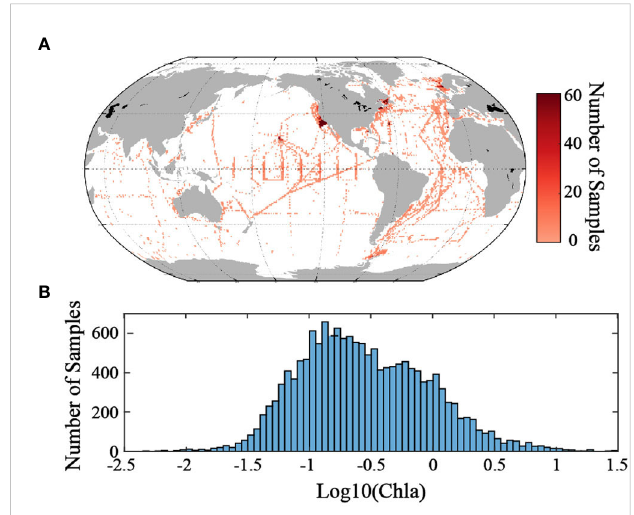
FIGURE 3 (A) Spatial and (B) numerical (bar plot) distribution of in situ Chla data matched up for the OC-CCI, GlobColour, and our merged products (15,599 in total); (Units of Chla: m